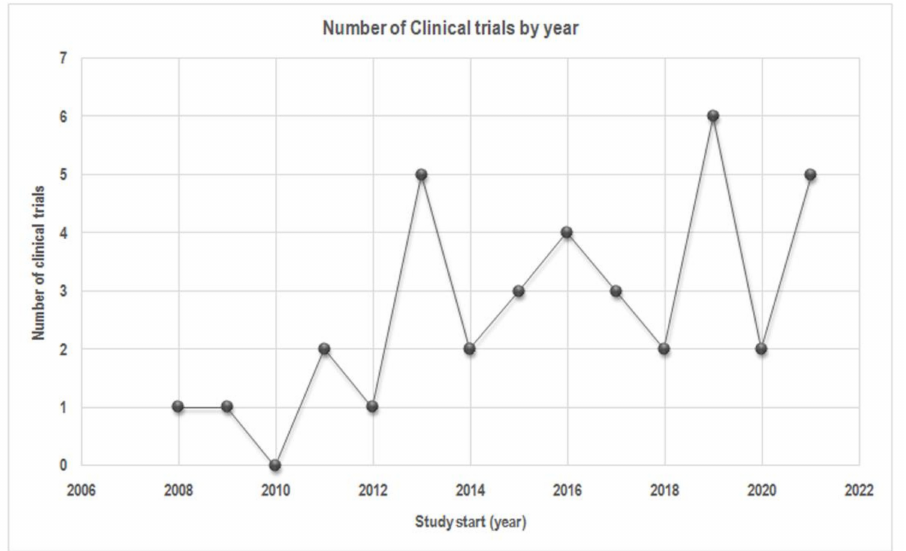
Figure 4. The number of clinical trials classified according to “Study Start.” Data from http://www. clinicaltrials.gov/ (15 March